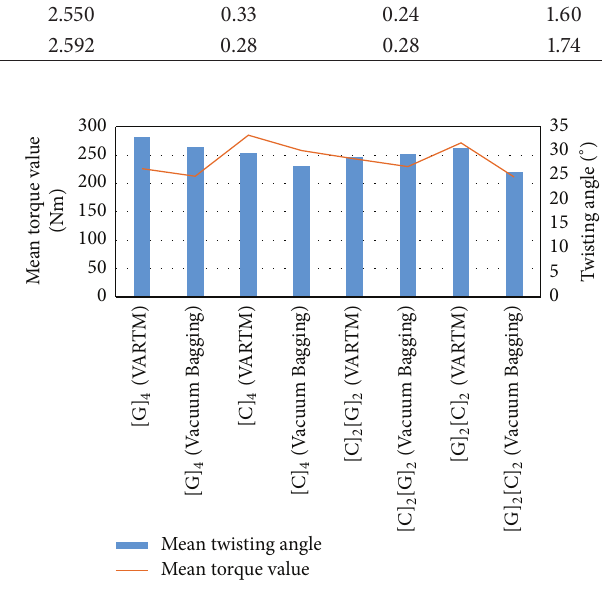
Figure 11: Comparison of mean torque and mean twisting angle values in terms of the manufacturing method and lay-up